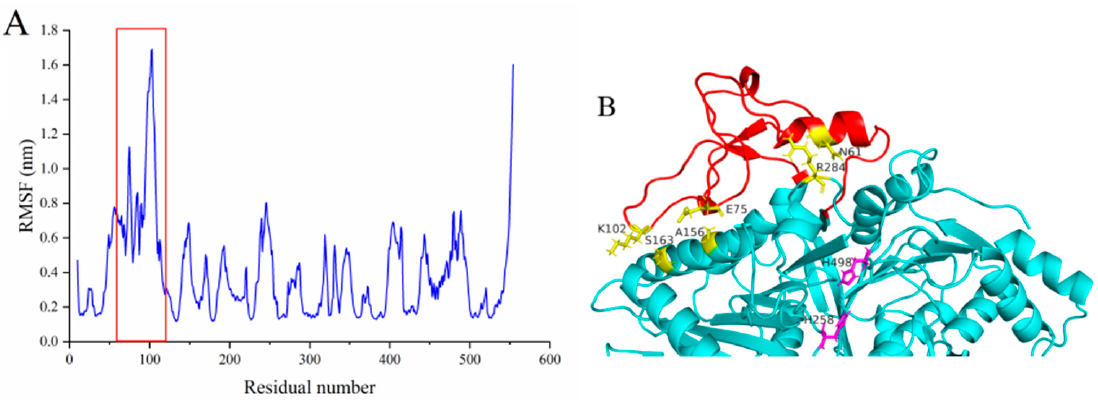
Figure 4. ( A ) RMSF plots for the MD simulations of wild-type MsPLD. Red box highlighted the RMSF value of the location of the extra loop of MsPLD. ( B ) Mutation sites selected for corresponding disulfide bonds construction are shown in yellow sticks. Two His258 and H498 located at the active site and the extra loop of MsPLD are shown in purple sticks and red color, respectively.